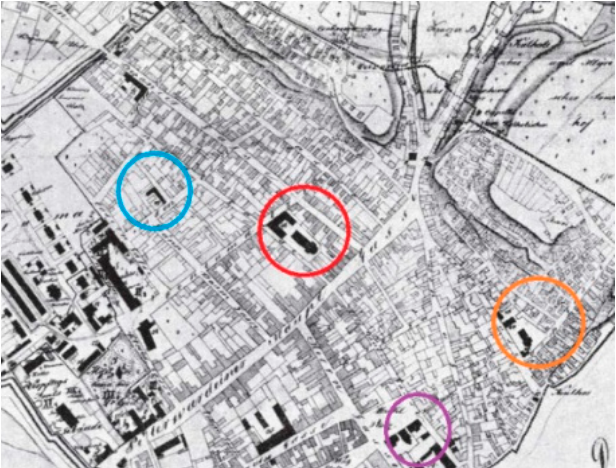
Figure 5. Carl Berthold’s Plan of the City of Zemun, 1830. The Jewish quarter is to the left, the Greek quarter is in the center and the Orthodox quarter is on the far right. The Catholic Church with the Great Square is underneath.